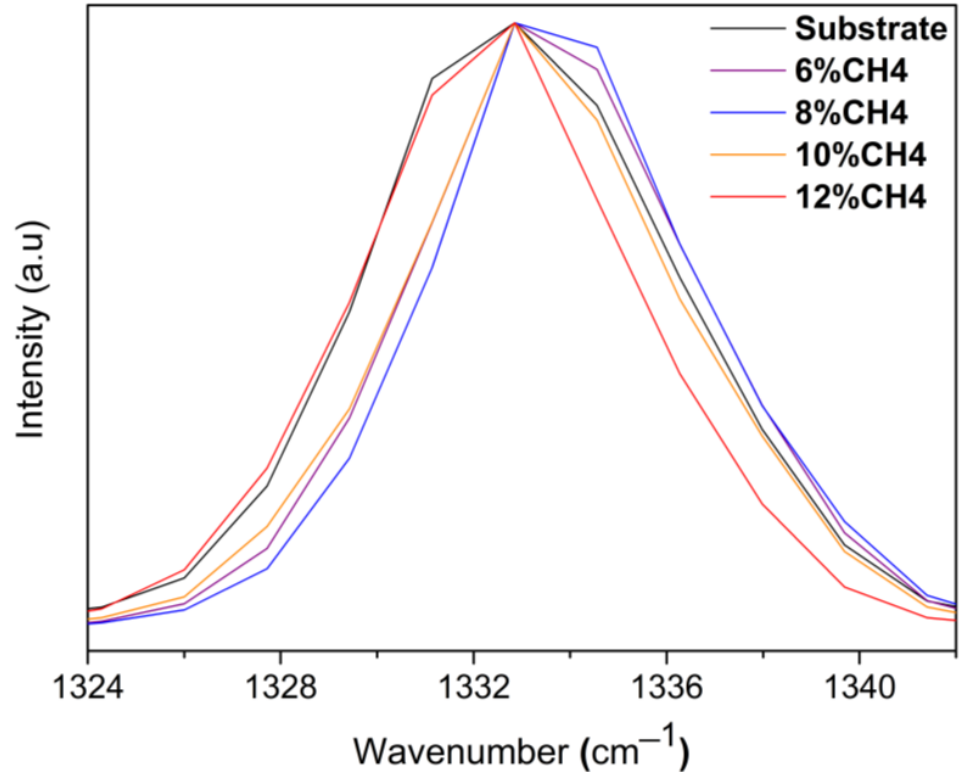
Figure 1. Raman spectra of as-grown MWPACVD diamond films on top of a diamond single-crystal seed substrate by varying CH 4 gas concentration of 2% to 12%.